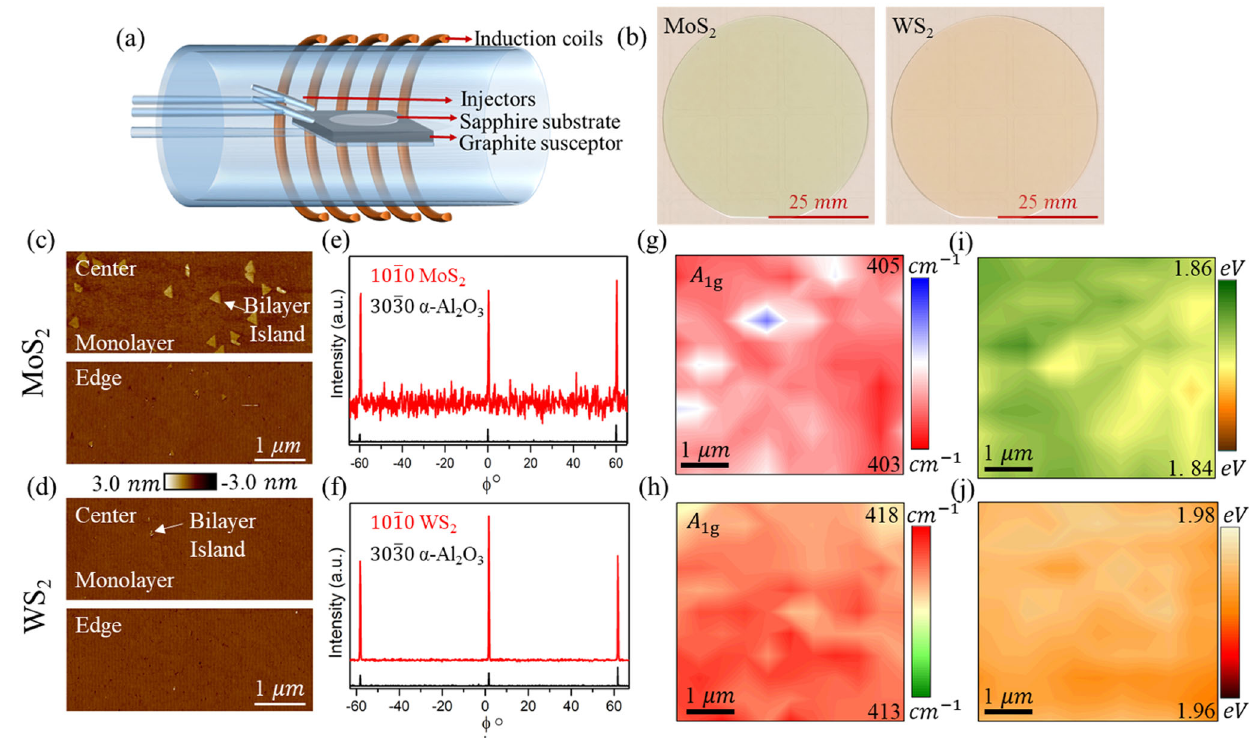
Fig. 1 Monolayer fi lm growth and characterization. a Schematic of the MOCVD system with a cold-wall horizontal reactor. b 2 ″ sapphire wafer with MOCVD grown MoS 2 and WS 2 . AFM images of c MoS 2 and d WS 2 at the center and edge of the respective wafers. Towards the center of the MoS 2 fi lm, few bilayers are seen. In-plane XRD ϕ -scan of e MoS 2 and f WS 2 on sapphire ( α -Al 2 O 3 ), showing the epitaxial relationship between the monolayers and the sapphire substrate. Raman map of the A 1g peak position for g MoS 2 and h WS 2 fi lms transferred from the growth substrate onto the device fabrication substrate with 50 nm ALD Al 2 O 3 . Low variation in the peak position is observed for both MoS 2 and WS 2 with an average of ≈ 403.5 cm − 1 and ≈ 417 cm − 1 , respectively. PL peak map of i MoS 2 with an average of ≈ 1.85 eV and j WS 2 with an average of ≈ 1.97 eV, con fi rm monolayer fi lms. PL is a characteristic of monolayer fi lm owing to indirect to direct bandgap measured. Figure 3a, b display the transfer characteristics of all measured MoS 2 and WS 2 FETs, respectively, for different L CH , which were used to extract key device parameters. For each parameter, the mean, median, standard deviation, minimum, and maximum values are reported. Finally, median values are used for benchmarking since they re fl ect the central tendency, even in the presence of outliers in the data, and offer higher accuracy in case of skewed distributions. Devices with the best number for a given parameter are termed as “ champion ” devices.